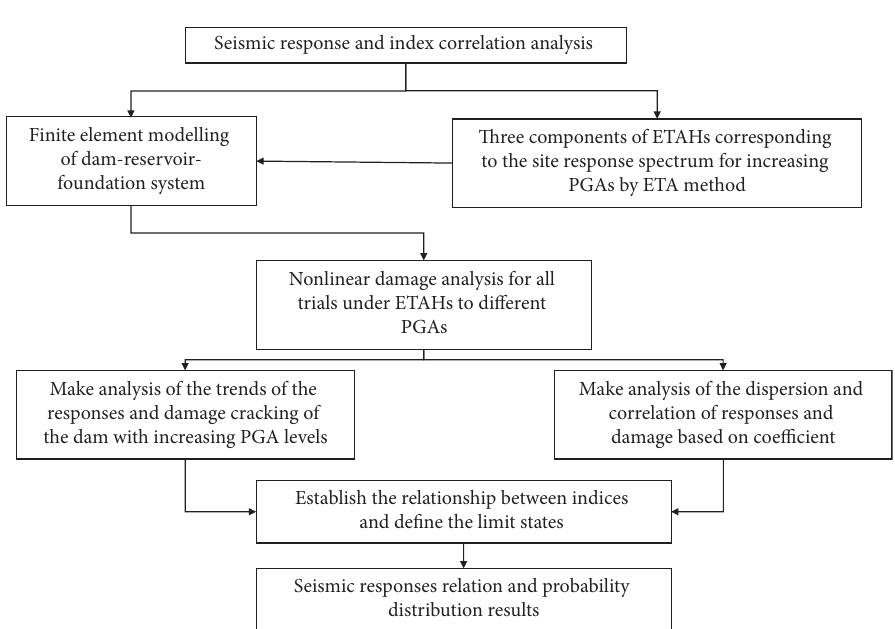
Figure 3: Flowchart: seismic response A contact boundary model is used to simulate the contraction joint [14, 45–47]. Figure 5(a) shows the master and slave surfaces in this model. Each node M on the slave